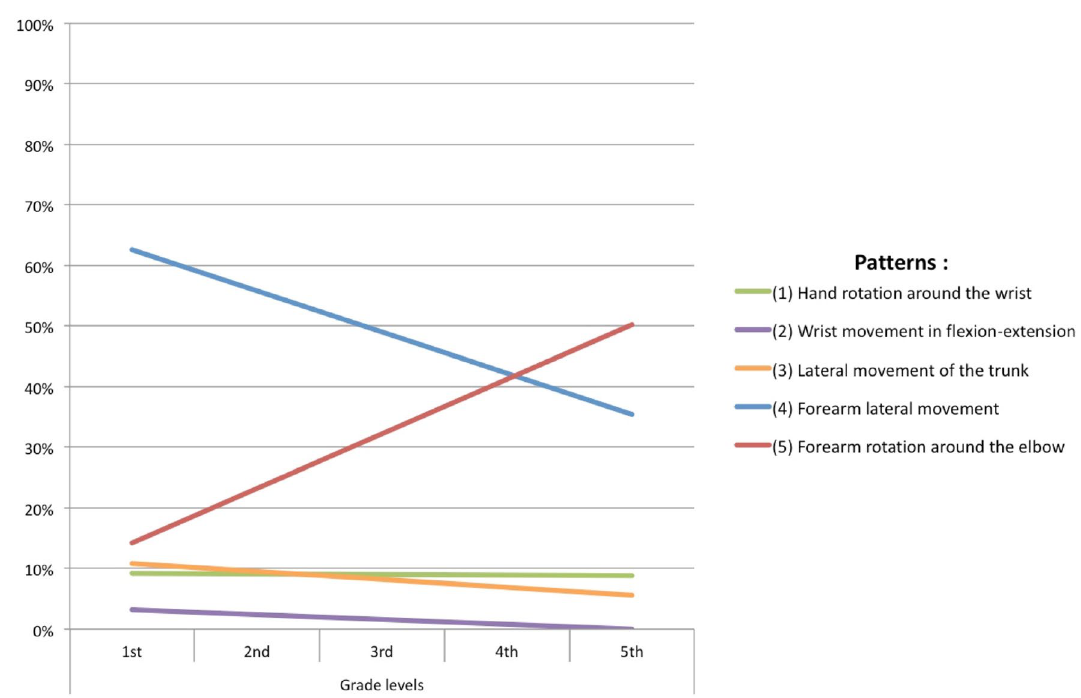
Figure 2. Main patterns (joints and inter-segmental linear regression) of arm movement when drawing a line of cycloid loops. Five significant patterns were described regarding inter-segmental postural and gestural displacements from 1st to 5th